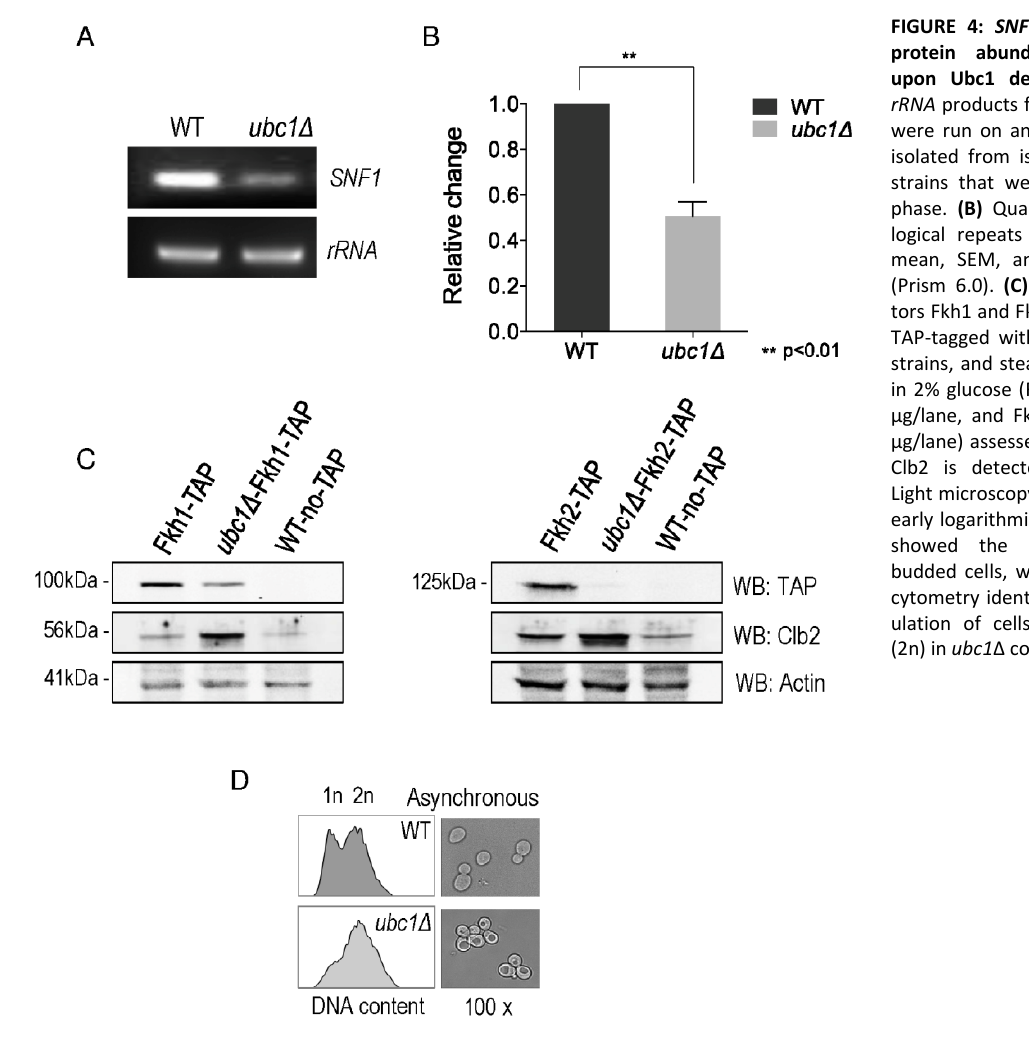
budded cells, with corresponding flow cytometry identifying the relative pop- ulation of cells with replicated DNA (2n) in ubc1 Δ compared to WT